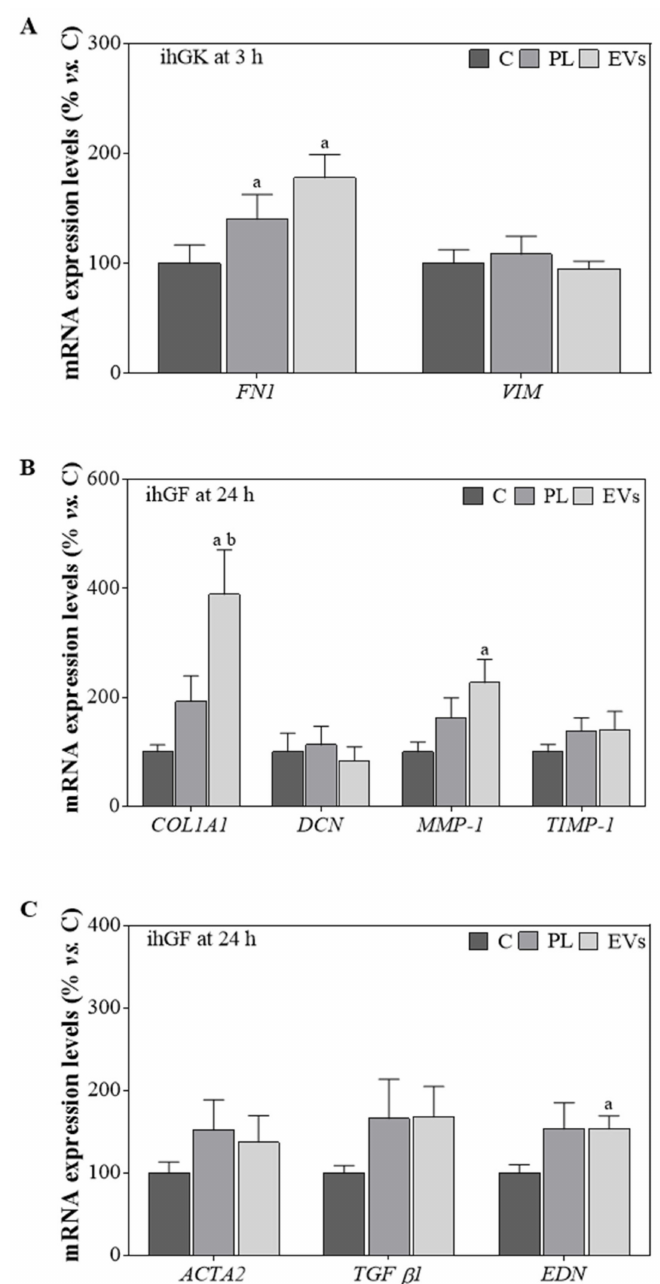
Figure 3. Gene expression levels in ihGK and ihGF after PL and EV treatment. ( A ) Effects on ihGK mRNA expression levels of FN1 and VIM after 3 h of treatment. ( B ) Effects on ihGF mRNA expression levels of COL1A1 , DCN , MMP-1 , and TIMP-1 after 24 h of treatment. ( C ) Effects on ihGF mRNA expression levels of TGF- β 1 , EDN , and ACTA2 after 24 h of treatment. Values represent the mean ± SEM. For ihGK, 9 independent experiments, with at least duplicate wells per group ( n = 9), were performed, while for ihGF, 8 independent experiments, with at least duplicate wells per group ( n = 8), were performed. Results were statistically compared by paired t -test. Statistically significant differences were considered for p < 0.05 and represented with “a” compared to C and “b” compared to